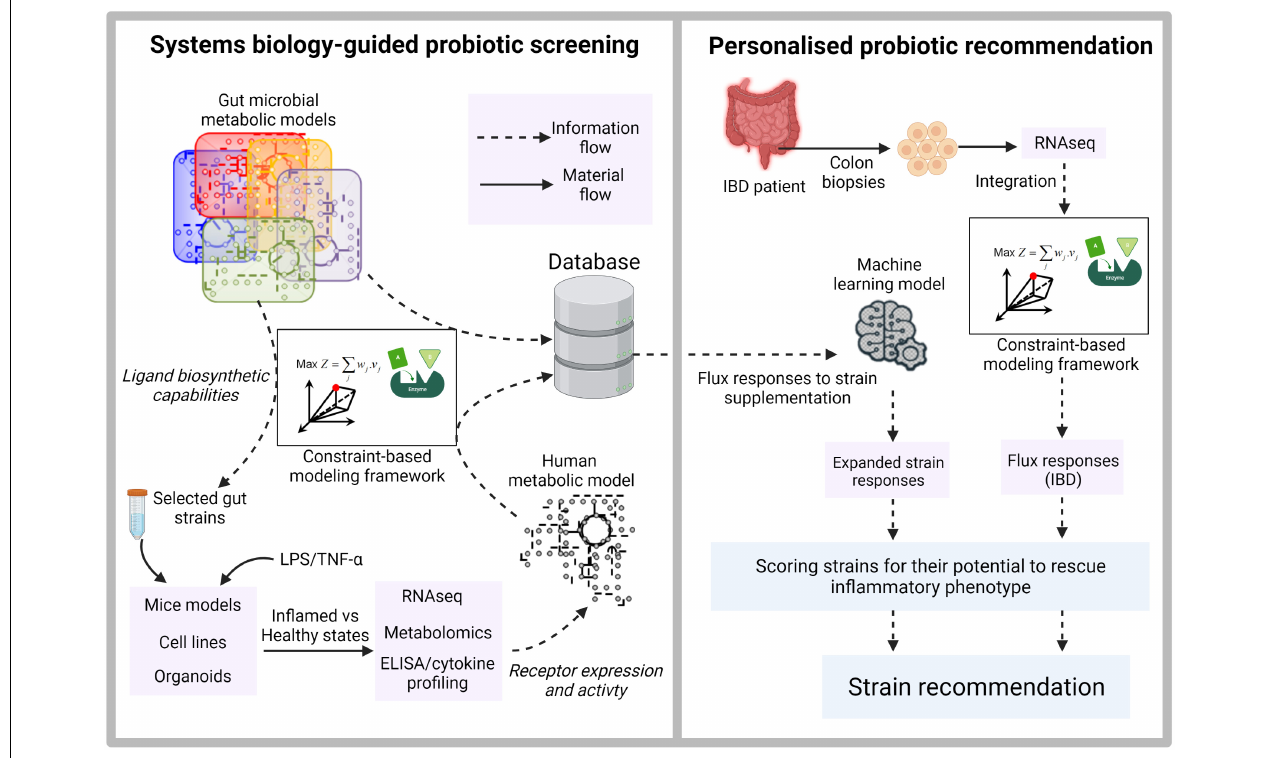
FIGURE 1 | Illustration of systems biology-guided personalized probiotic recommendation. The first stage consists of constraint-based model-driven screening of gut microbial strains for the production of diverse ligands capable of binding to human receptors. The secretory metabolites from selected strains are then used to treat mice models, cell lines or organoids. Their inflamed and healthy states are quantified using inflammatory cytokine profiling. Paired RNAseq and metabolomic datasets derived from each probiotic supplementation scenario provide information on the expression and activity of the target receptors and serve as constraints to derive context-specific models from a generic human genome-scale metabolic network. The context-specific models are used to derive flux responses corresponding to the supplementation of each probiotic strain. The second stage involves training a machine learning model using the extensive flux response information derived in the first stage. RNAseq data derived from real IBD patients for whom the probiotic recommendations are to be made is used to generate a context-specific model and the corresponding metabolic flux distribution. This flux distribution is then used as an input to the trained machine learning model to rank strains based on their ability to rescue the inflammatory